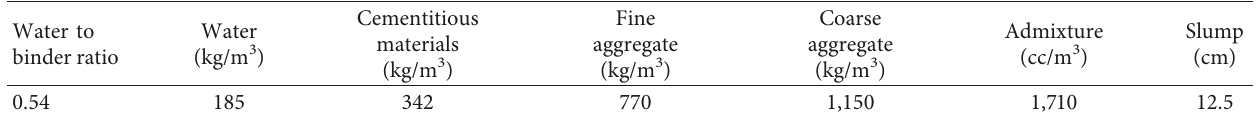
Figure 3: Panel geometry and bolt arrangement (unit: mm). (a) No bolt. (b) 4 bolts. (c) 6 bolts. (d) 8 Table 2: Mix proportion of concrete.